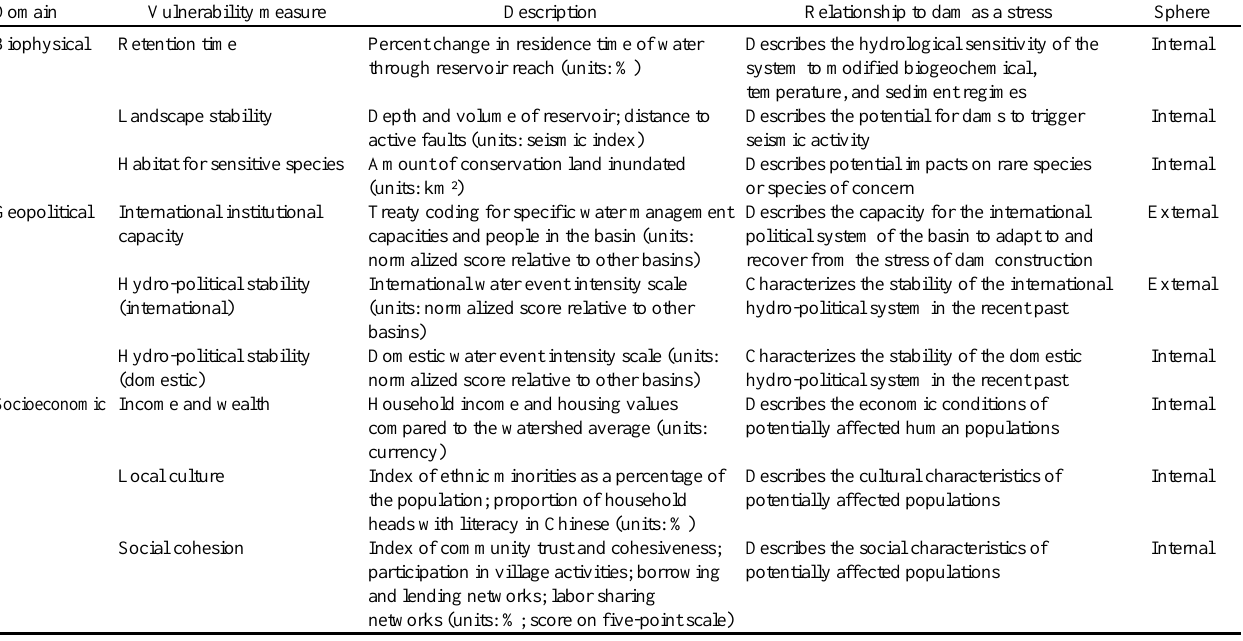
Table 3. Framework for characterizing vulnerability for the Nu River case study of four proposed hydroelectric dams. Consistent with Füssel (2007), sphere is identified as internal or external depending on whether they are properties of the vulnerable system or are factors outside of that system,